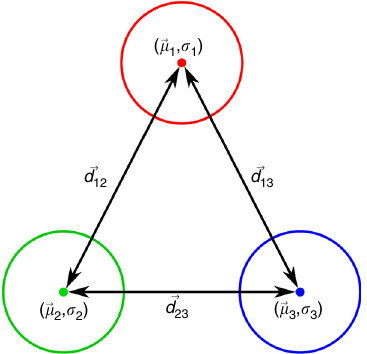
! ! ! d d 12 , 13 , and 23 ) for